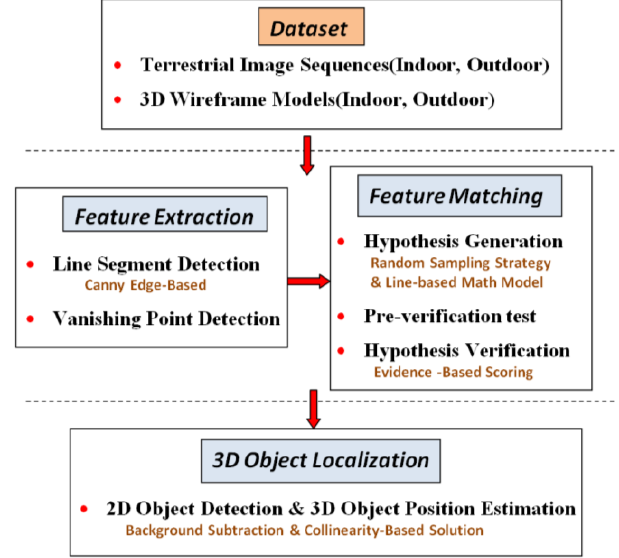
Figure 2. General overview of proposed